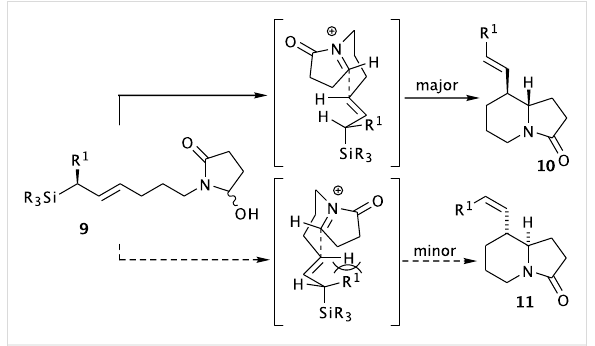
Figure 1: Rationale for stereoselective assembly of the indolizidine core using chiral allylsilanes.